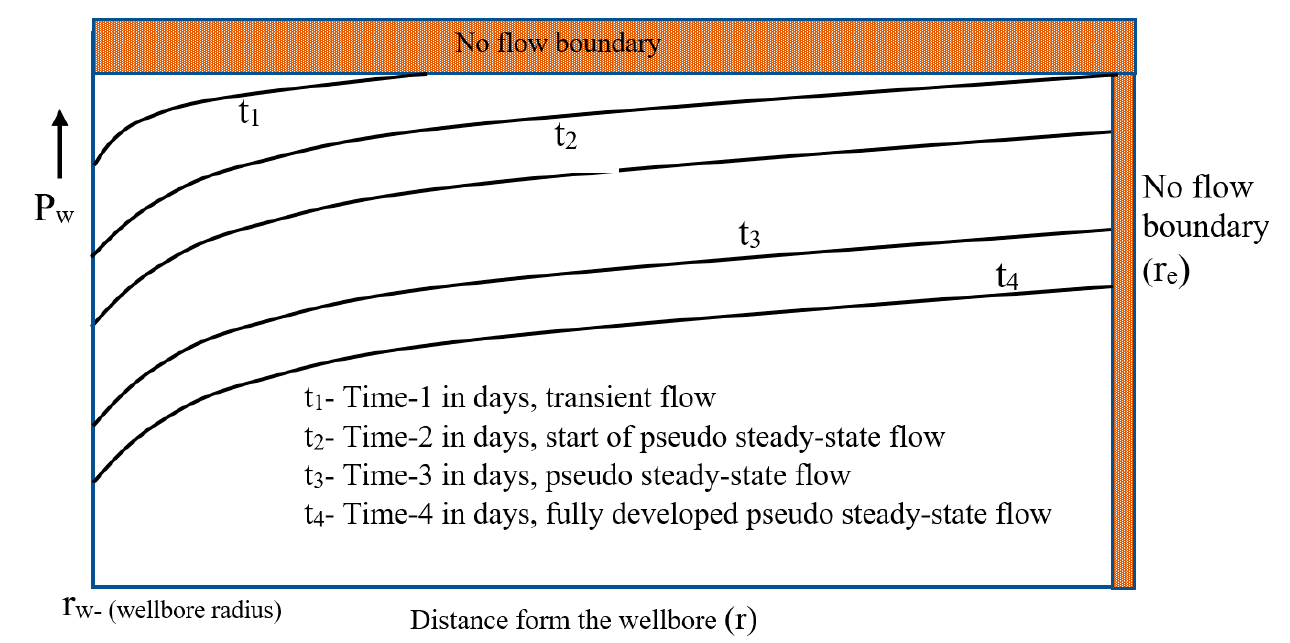
Figure 1. Pressure versus radius in pseudo ‐ steady state flow regime [17].